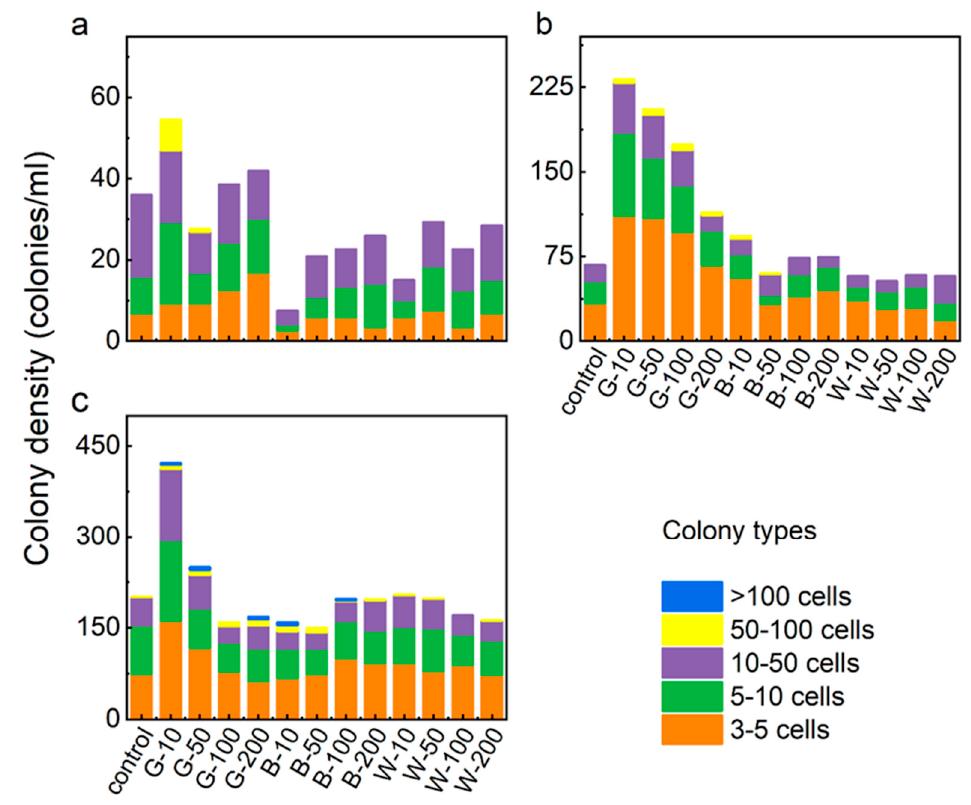
Figure 3. The colony formation of M. aeruginosa exposure to mPET at different times (( a ): 13d; ( b ): 19d; ( c ): 25d). G–10 refers to green–10 mg/L mPET, B–10 refers to black–10 mg/L mPET, W–10 refers to white–10 mg/L mPET and the rest may be deduced by analogy.